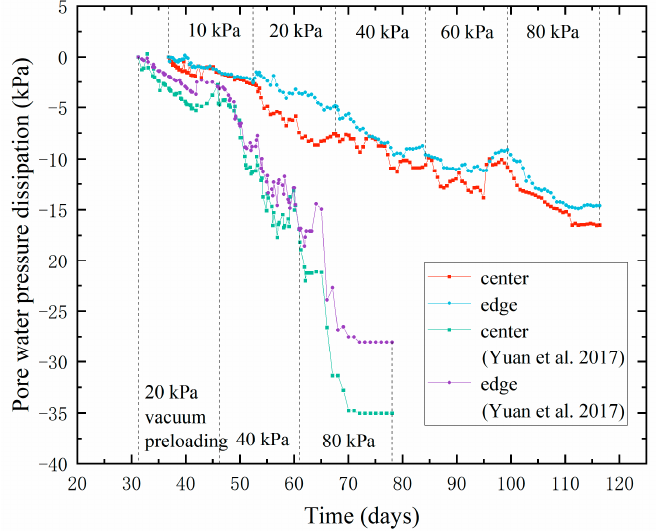
Figure 8. Dissipation of pore water pressure by step vacuum preloading (SVP) with different loading modes.